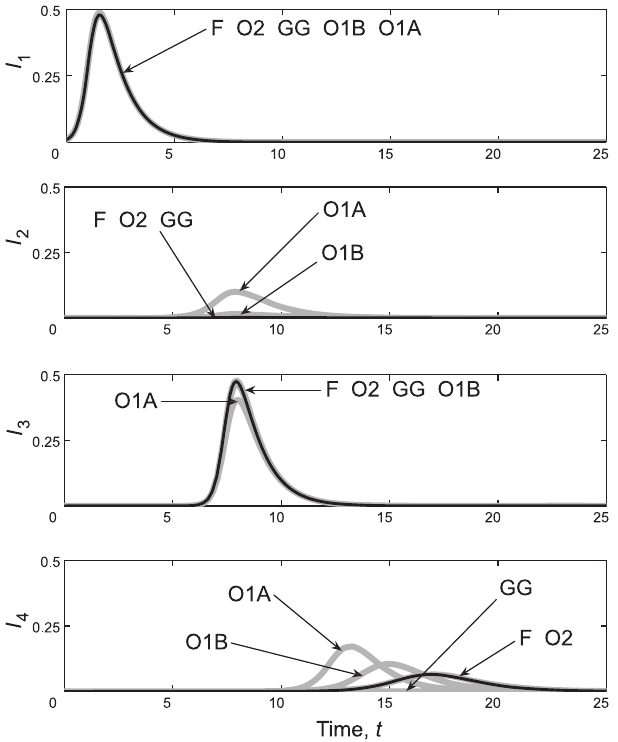
Figure 3. Dynamics of the Full Four-Strain SIR Model (Black Curves) Compared with Its Approximations (Thick Gray Curves) Solution of the full model, Gog and Grenfell’s model, order-1 independence closure model, order-1 interpolation closure model, and order-2 independence closure model are denoted by F, GG, O1A, O1B, and O2, respectively. Parameter values: m ¼ 10 (cid:4) 6 , R 0 ¼ 5, and s ¼